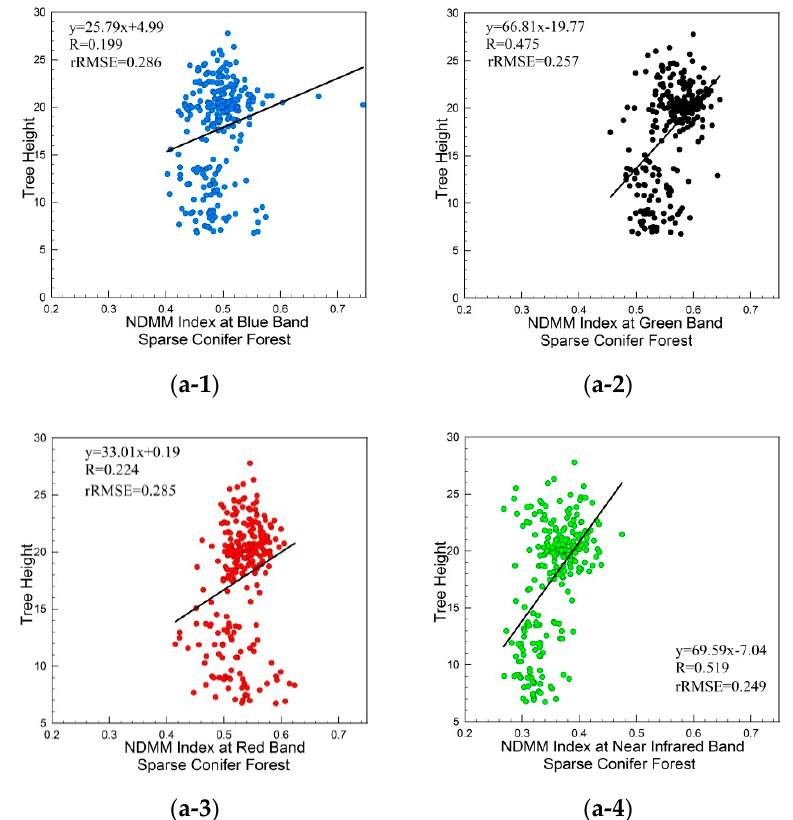
Figure 8. Relationship between tree height and NDMM index in four bands for sparse confer forests in Howland. ( a-1 ), ( a-2 ), ( a-3 ) and ( a-4 ) represent the relationship between the tree height and NDMM Index at blue, green, red and near-infrared band for sparse conifer forests respectively.